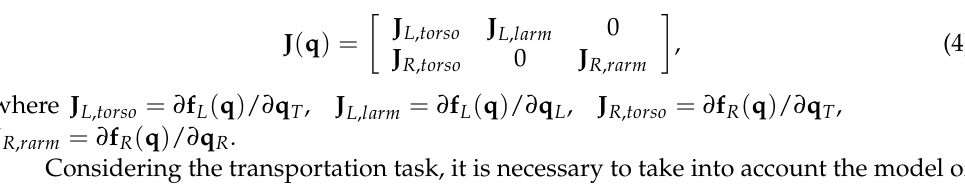
left and right arms, respectively. q T is the joint angle of the last joint of the torso and is used to compensate q T pi /2 q T 3 2 − − the rotations of the two previous joints. q L and right arms, respectively. The rotation axes of the independent joints of the torso